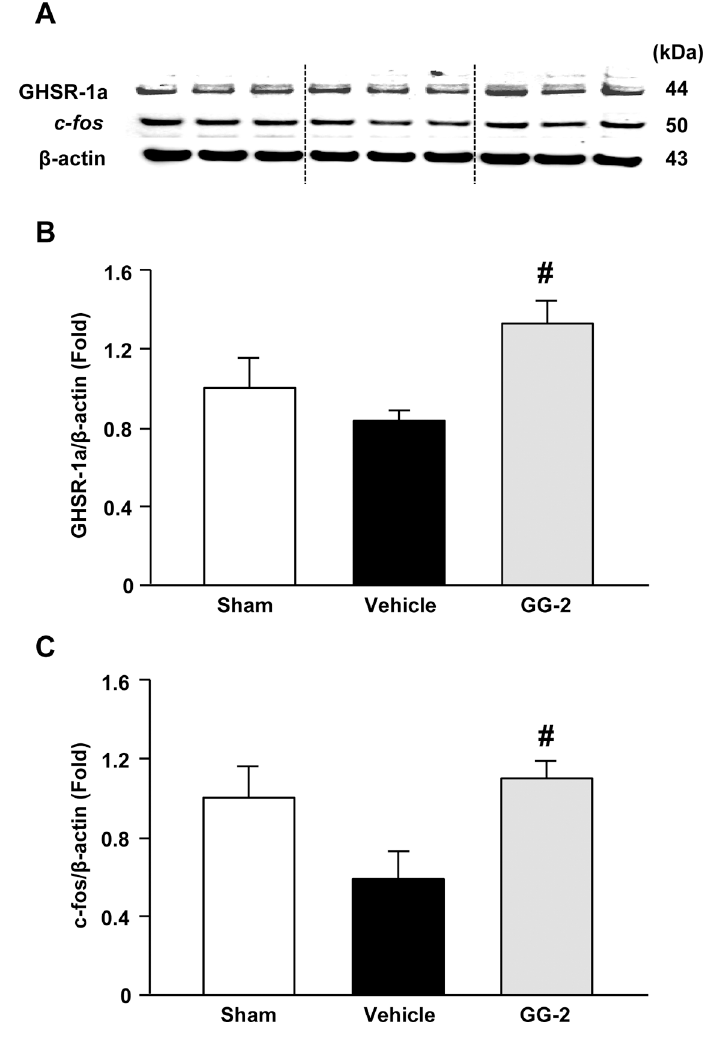
Figure 9. Effect of the combined treatment on brain activity in aged septic rats. Rats were sham operated or subjected to CLP with injection of vehicle (normal saline) or GG-2 (80 nmol/kg of ghrelin and 50 μ g/kg of GH) at 5 h after CLP. The brainstem was har- vested at 20 h after CLP for protein extraction. (A) Representative Western blots against GHSR-1a, c-fos and β -actin. Quantitative levels of (B) GHSR-1a and (C) c-fos in different groups. Blots were scanned and quantified with densitometry. The levels of protein ex- pression in sham group are designated 1 for comparison. Data are expressed as mean ± SE (n = 5–7 per group). # P < 0.05 versus